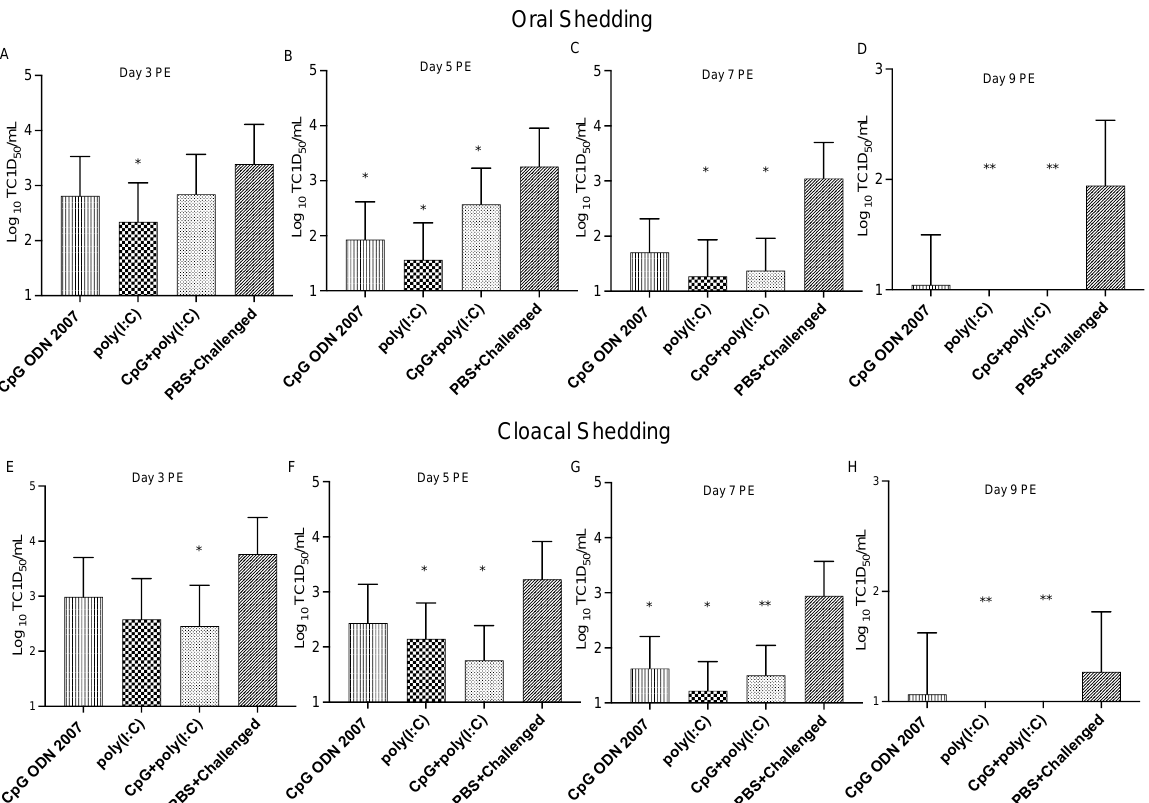
Figure 6. Virus titers in oral and cloacal swabs in the TLR ligand-treated exposed chickens on days 3-, 5-, 7 and 9 post-exposure (PE). The figure represents the mean virus shedding titers (log 10 transformed) of H9N2 AIV (expressed as TCID 50 /mL) in oral ( A – D ) and cloacal swabs ( E – H ) on days 3-, 5-, 7- and 9 PE in the exposed groups. The chickens were treated with 100 µ L of CpG ODN 2007 (10 µ g/chicken) and poly(I:C) (400 µ g/chicken), a combination of CpG ODN 2007 (10 µ g/chicken) + poly(I:C) (400 µ g/chicken) or 100 µ L PBS for the positive and negative control group. After eighteen hours of TLR ligand treatment, the treated chickens were exposed to H9N2 AIV-contaminated feces in the isolator (except the negative control group). Statistical analysis was done by one-way ANOVA followed by Tukey’s post hoc test (parametric). When data were non-parametric, a Kruskal–Wallis test was performed. *: p < 0.05 or **: p < 0.01 (vs. PBS control). Administration of poly(I:C) also led to a significant reduction in cloacal shedding